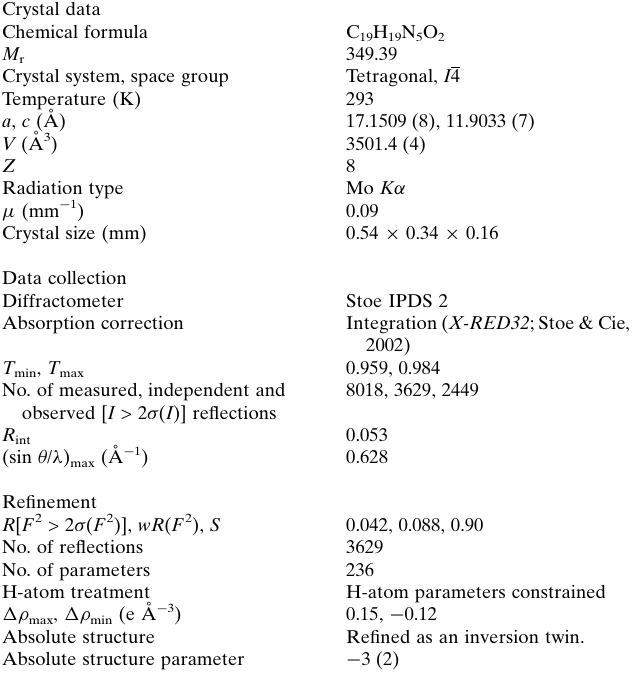
Table 2 Experimental details.